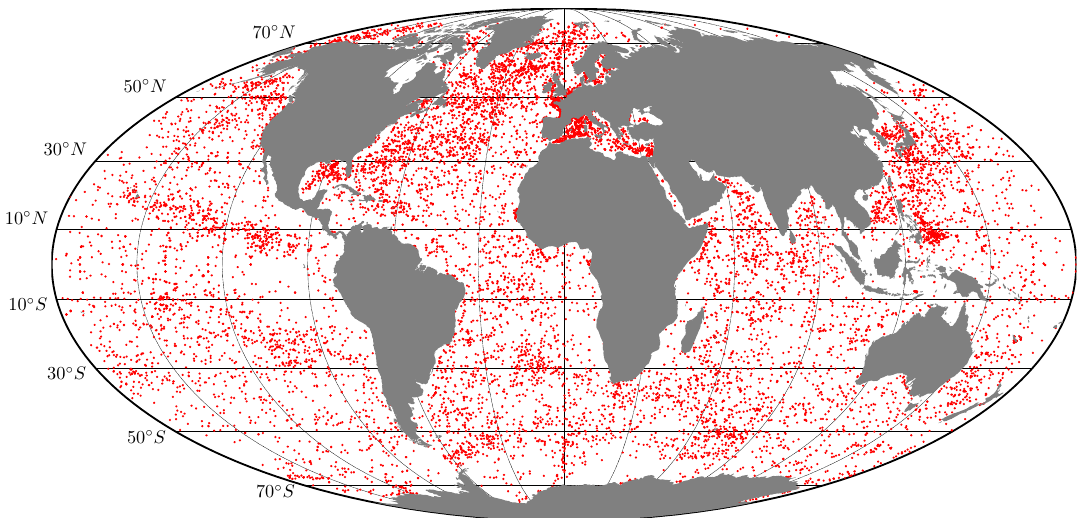
Figure 1. Map of the available platforms since 2015 containing salinity and temperature data (approx. 4600 valid platforms.